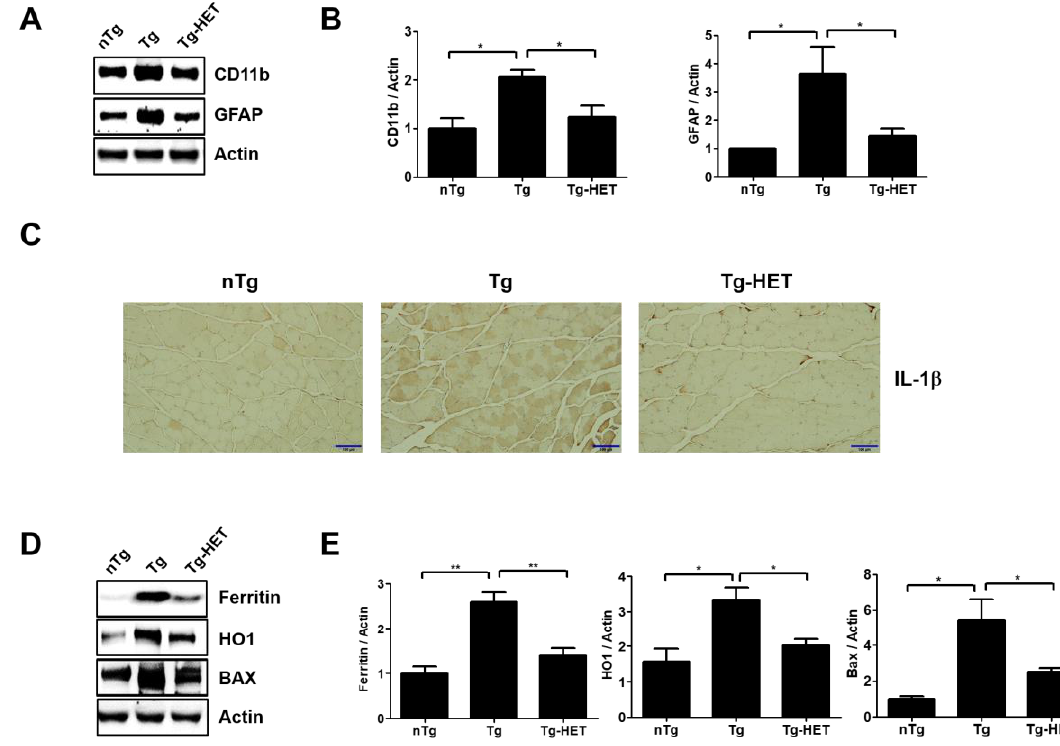
Figure 4. Hochu-ekki-to (HET) treatment enhances anti-inflammation, anti-oxidative stress effects, and regulates autophagy in the gastrocnemius of an ALS mouse model. ( A ) Representative Western blots of inflammatory related proteins, CD11b and GFAP, in the gastrocnemius of each group. Actin was used as a loading control. ( B ) Quantification of the expression levels of CD11b/Actin and GFAP/Actin. ( C ) Representative images of IL-1 β immunostaining in the gastrocnemius of each group. Scale bars = 100 µ m ( D ) Representative images of oxidative stress-related proteins (Ferratin, HO1, and BAX) in the gastrocnemius of each group. ( E ) Quantification of the expression levels of Ferritin / Actin, HO1 / Actin, and BAX / Actin. Data are presented as the mean ± SEM ( n = 3 / group). * p < 0.05, ** p < 0.01. nTg: non-transgenic mice, Tg: hSOD1 G93A , Tg-HET:HET-treated hSOD1 G93A